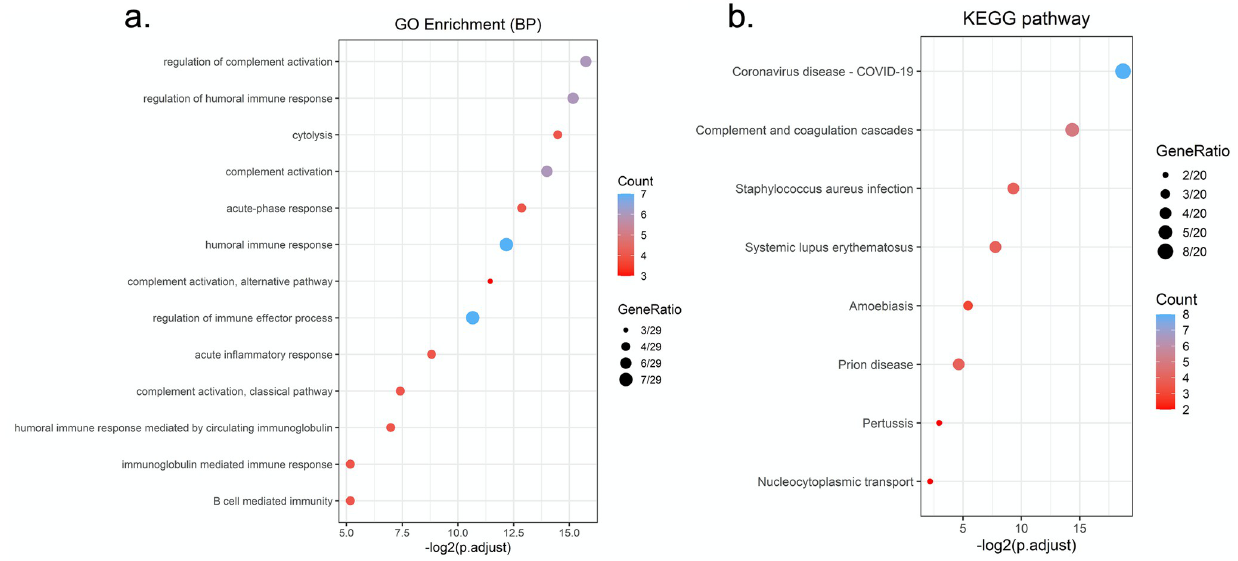
Fig 3. Proteomics alterations, associated pathways and diseases. (a) Shows the top 13 Pathways enriched in significantly up- and down- regulated proteins using Gene Ontology (GO) biological process (BP) Enrichment. GO-based enrichment analysis of DEPs shown in the term of biological processes (two-sided hypergeometric test; p < 0.05) and the number of counts (Count > 3). GO terms were sorted by adjusted p-values using the Benjamini- Hochberg method. (b) Shows the top 8 diseases associated with the significantly up- and down- regulated proteins using the KEGG pathway. KEGG-based enrichment analysis of DEPs (two-sided hypergeometric test; p < 0.05) and the number of counts (Count > 2). KEGG terms were sorted by adjusted p- values using the Benjamini-Hochberg